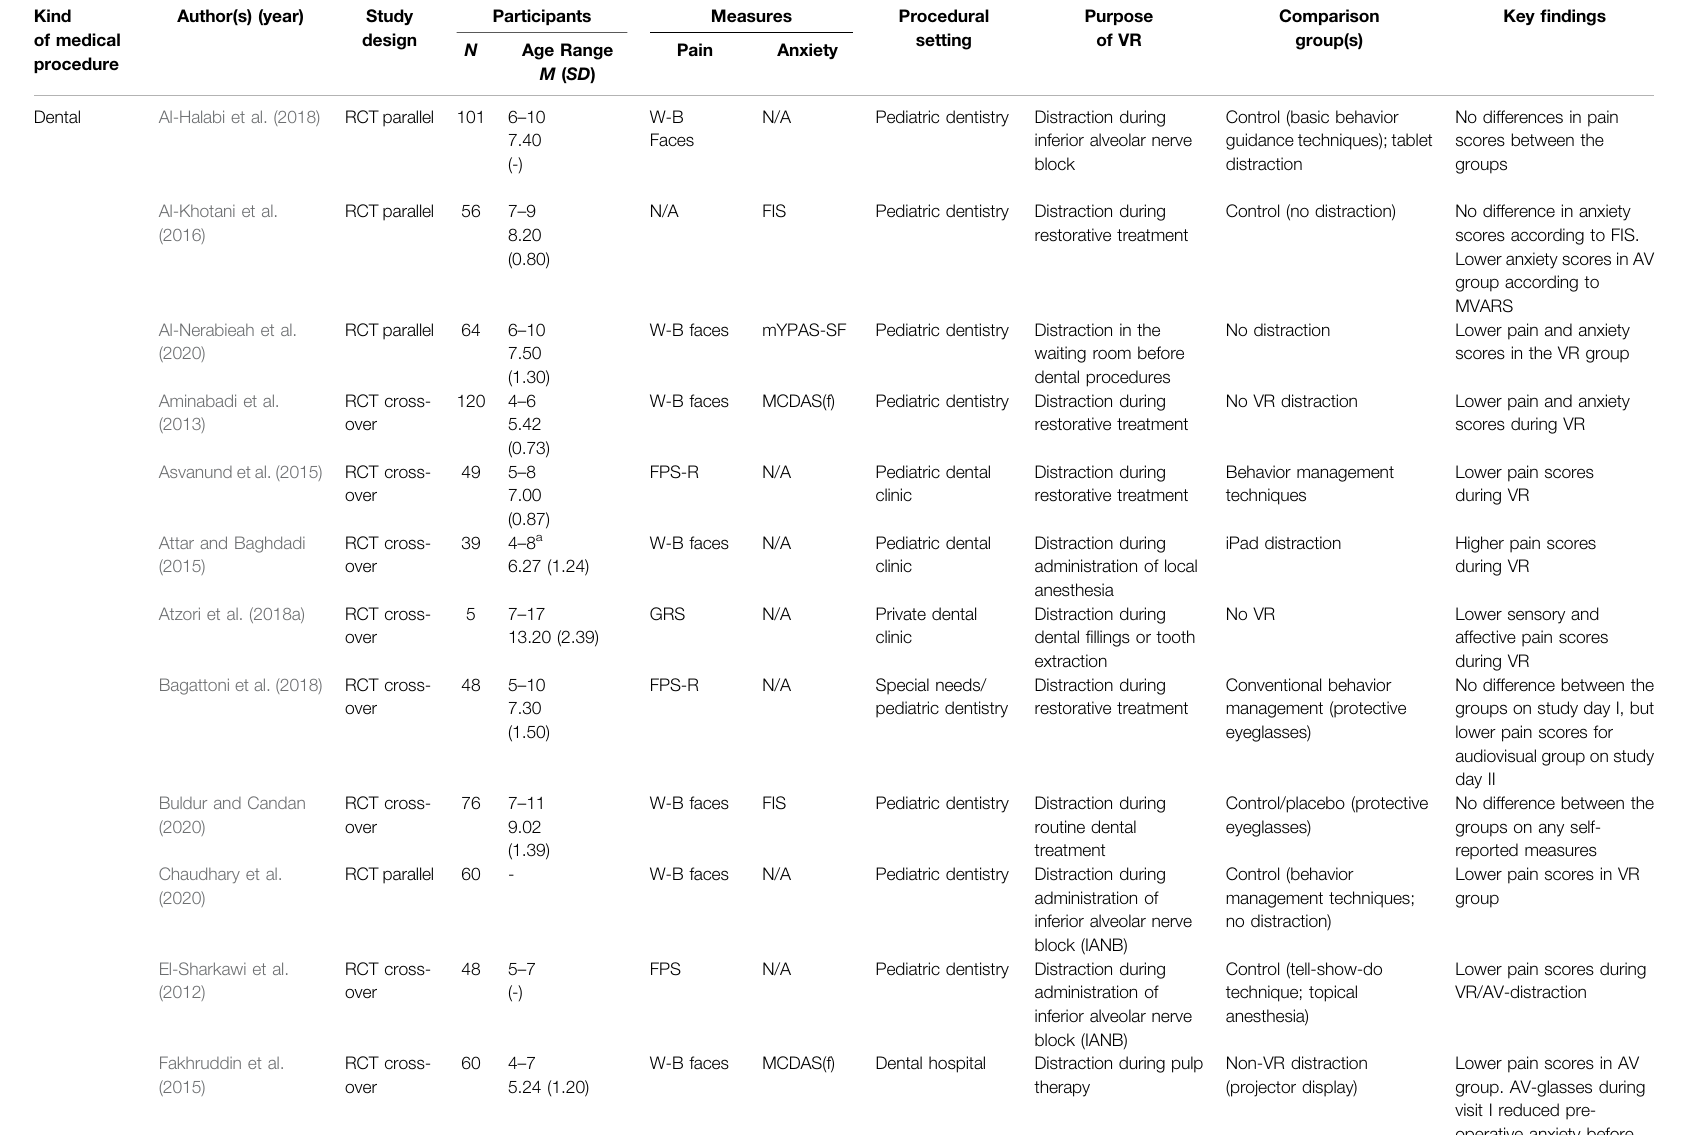
TABLE 2 | Study characteristics and